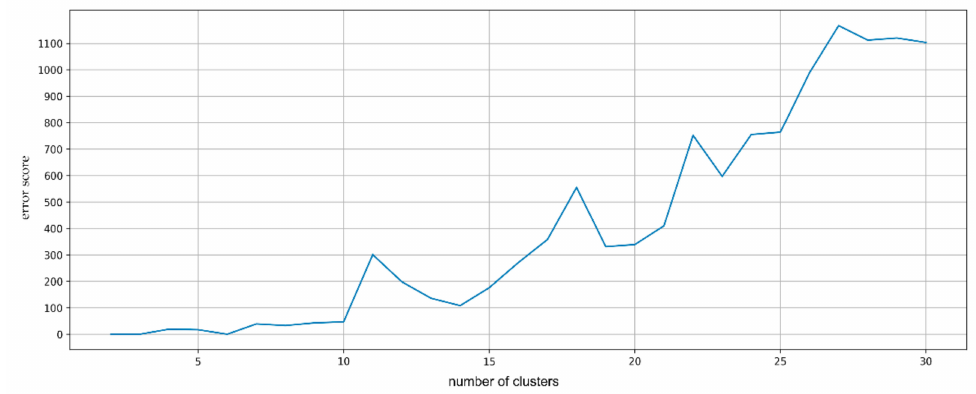
Figure 8. Overall stability error of the distribution method with respect to the number of